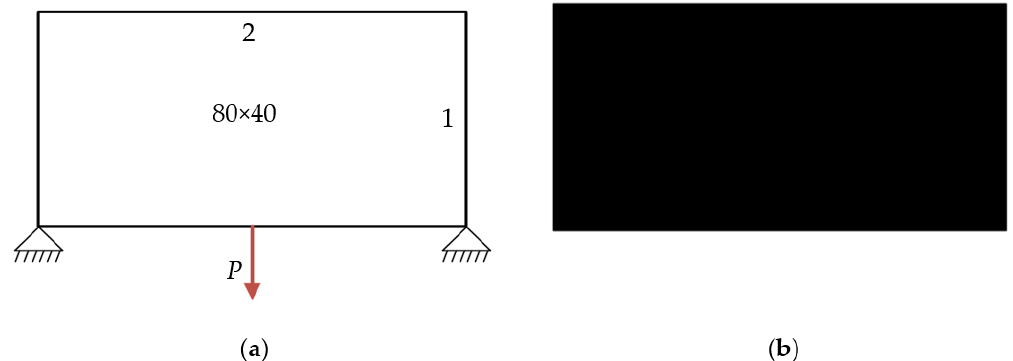
Figure 4. Optimal design problem of two-dimensional simple bridge beam, ( a ) design domain and boundary conditions; ( b ) initial shape.